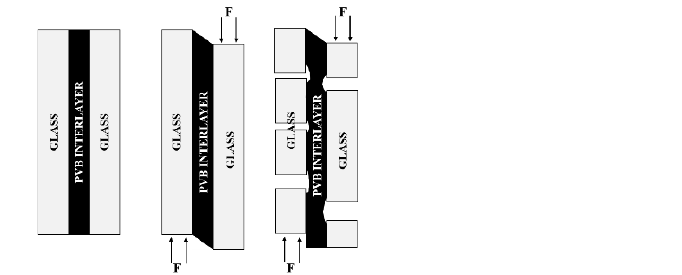
Fig. 13 Effects of glass fracture on interlayer confinement and deformation highlighting regions of interlayer stress relaxation and stretching correlating to regions of glass fracture within the